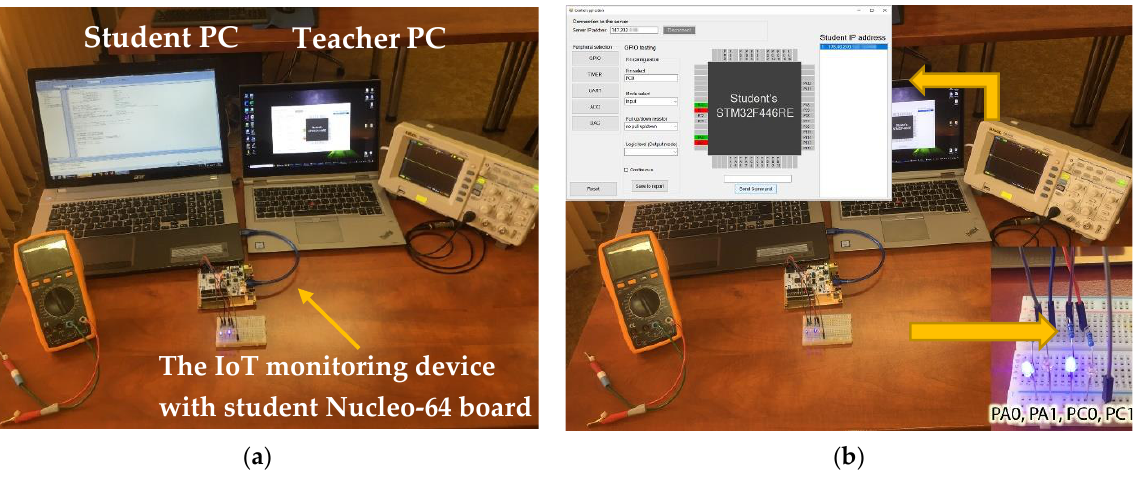
Figure 10. ( a ) Workplace of a remote laboratory with a teacher PC, a student computer, and the IoT monitoring device with measuring devices (multimeter and oscilloscope). ( b ) GPIO pins monitoring where PA0, PA1, PC0, and PC1 pin was tested.